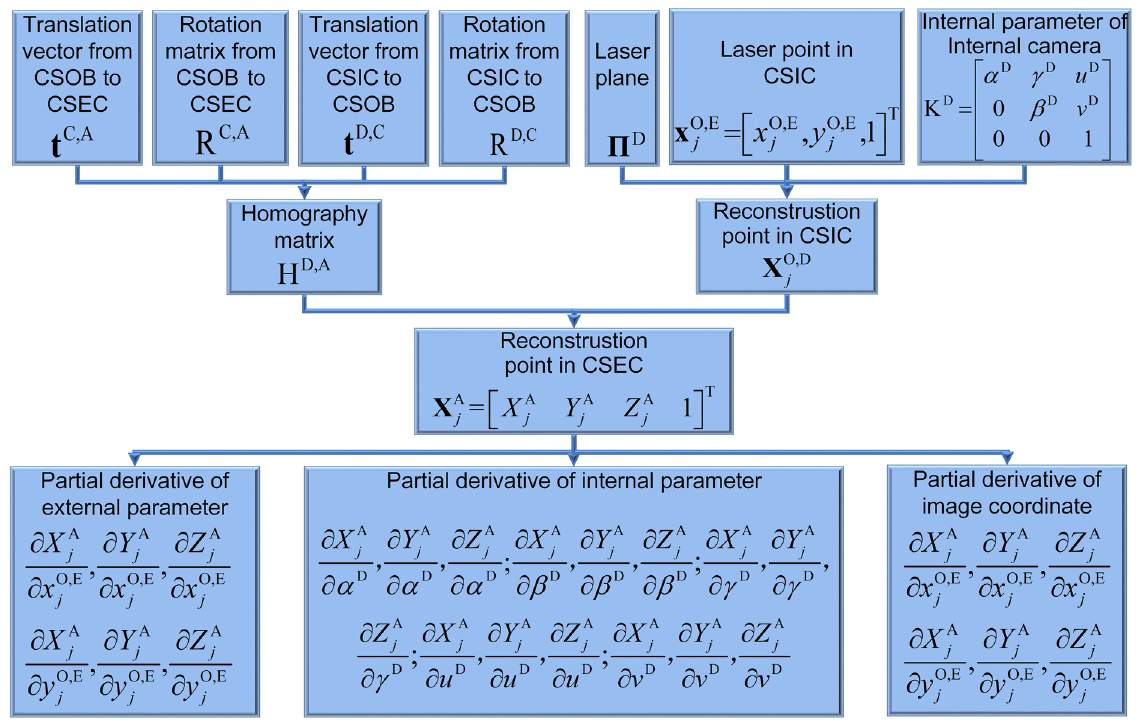
Figure 2. The generations of the partial derivatives of system structure parameters and image coordinates. O,D X A H D,A is the homography from CSIC to CSEC. X j is the 3D reconstruction point in CSIC. j is the spatial coordinate of the laser point in CSEC. The partial derivatives of the external parameters, internal parameters and image coordinates are generated to the variation ratio of the spatial point in